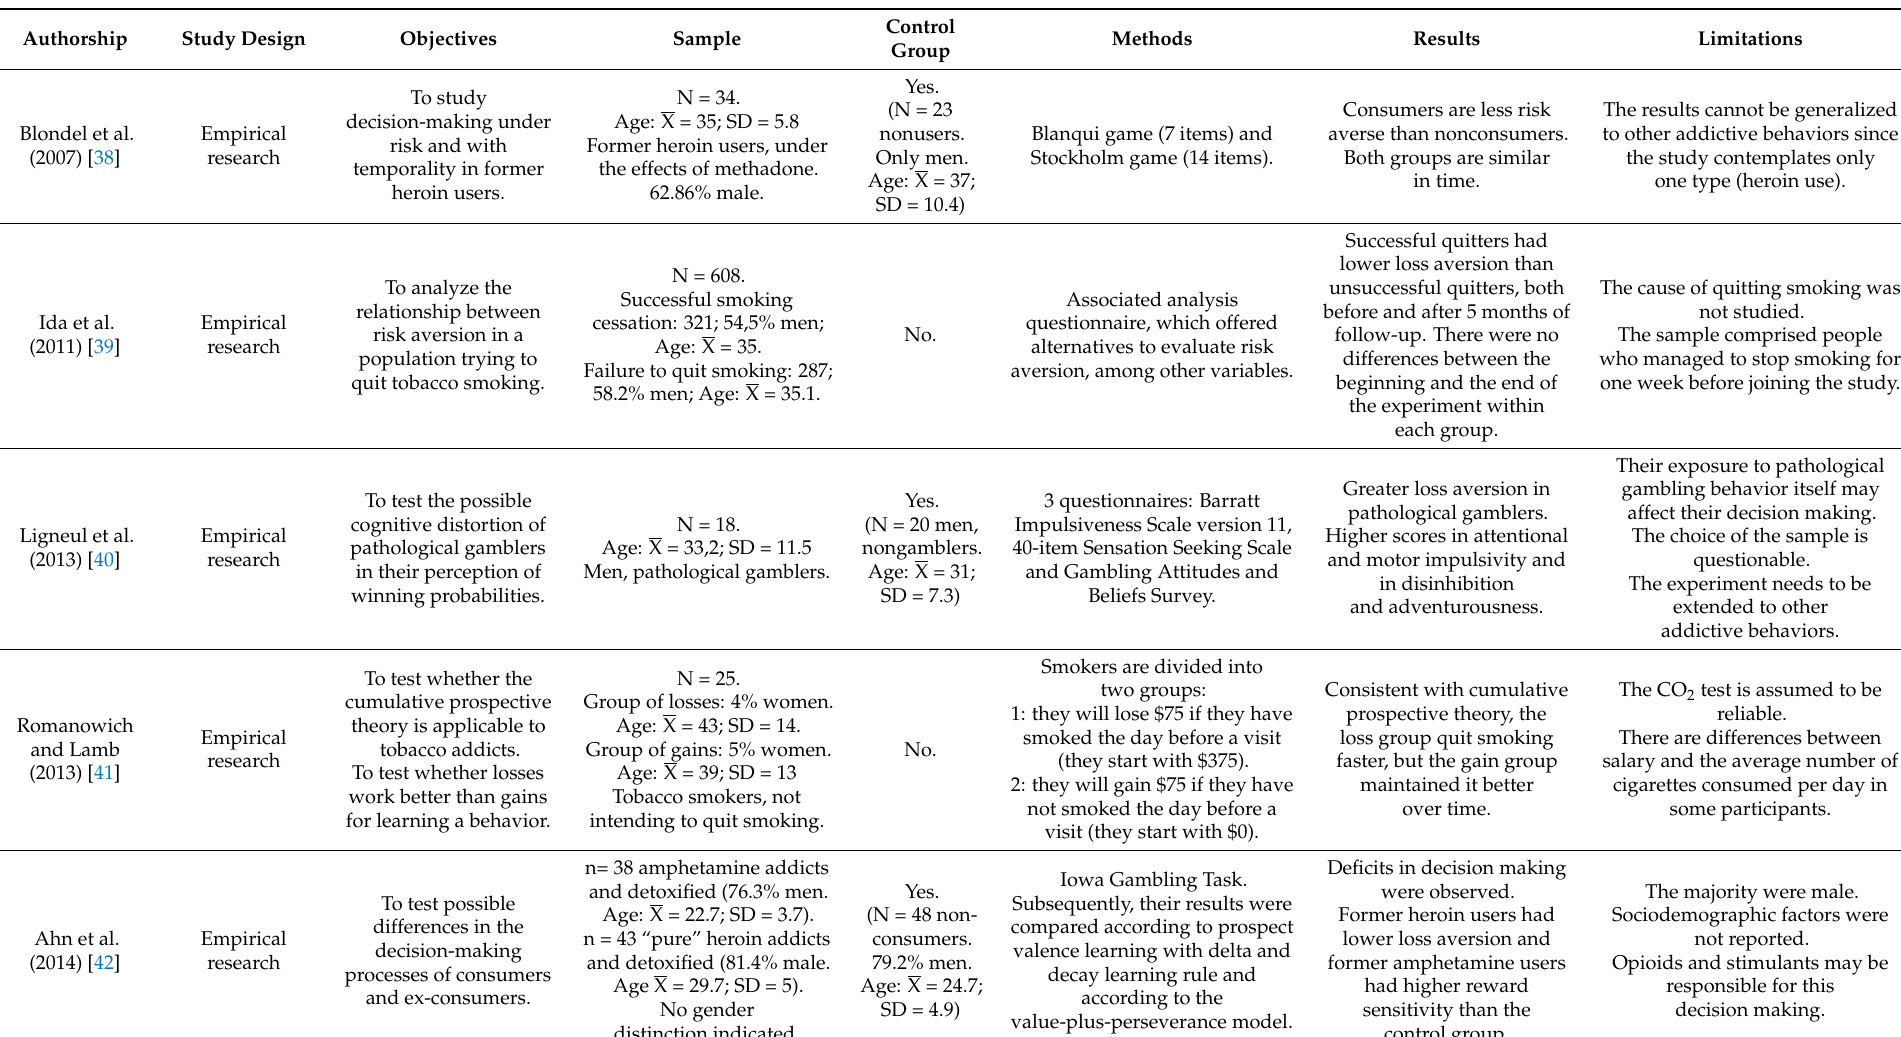
Table 1. Systematic information of the studies chosen for the